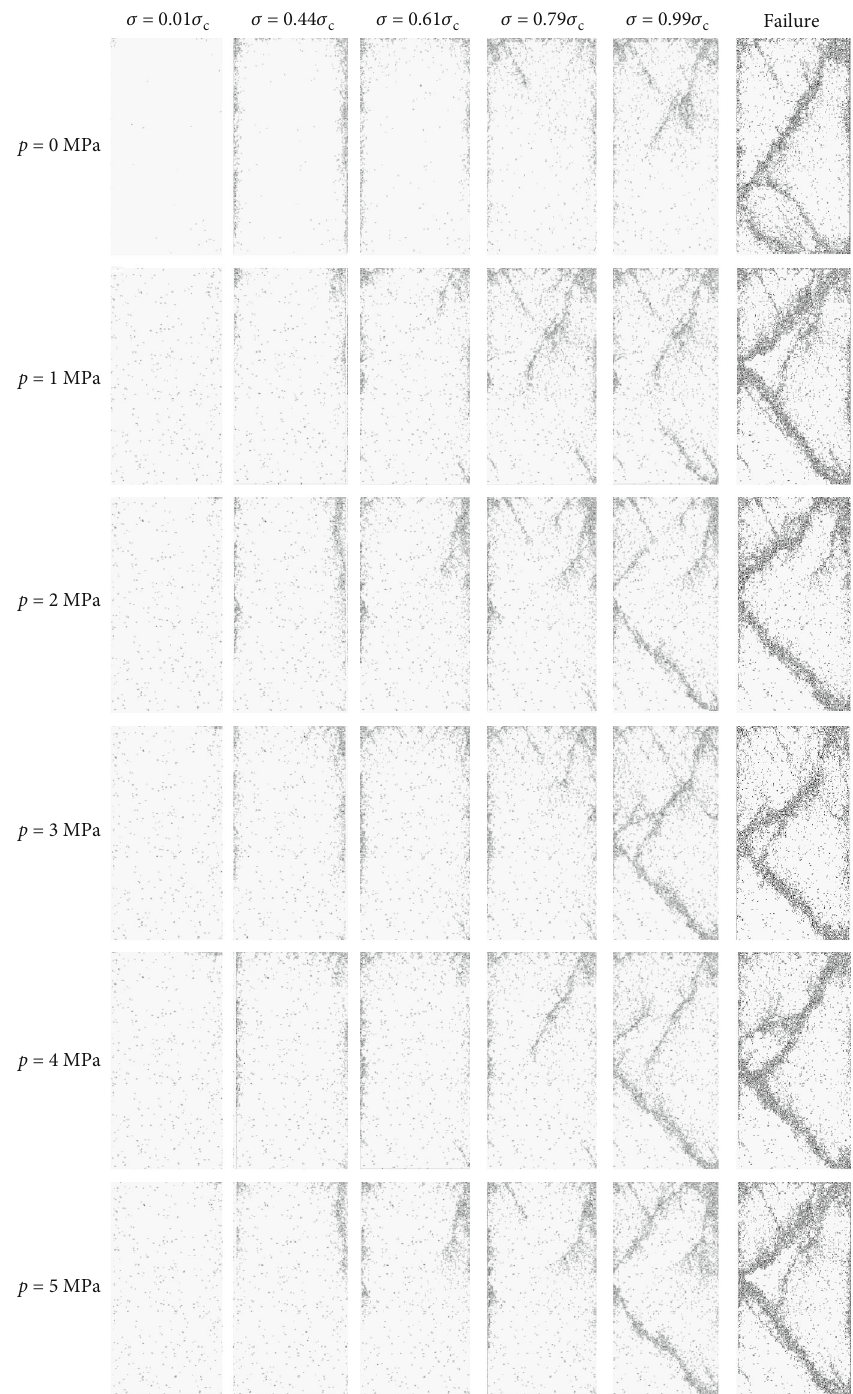
Figure 10: Distribution and evolution of cracks in gas-containing coal under di ff erent gas